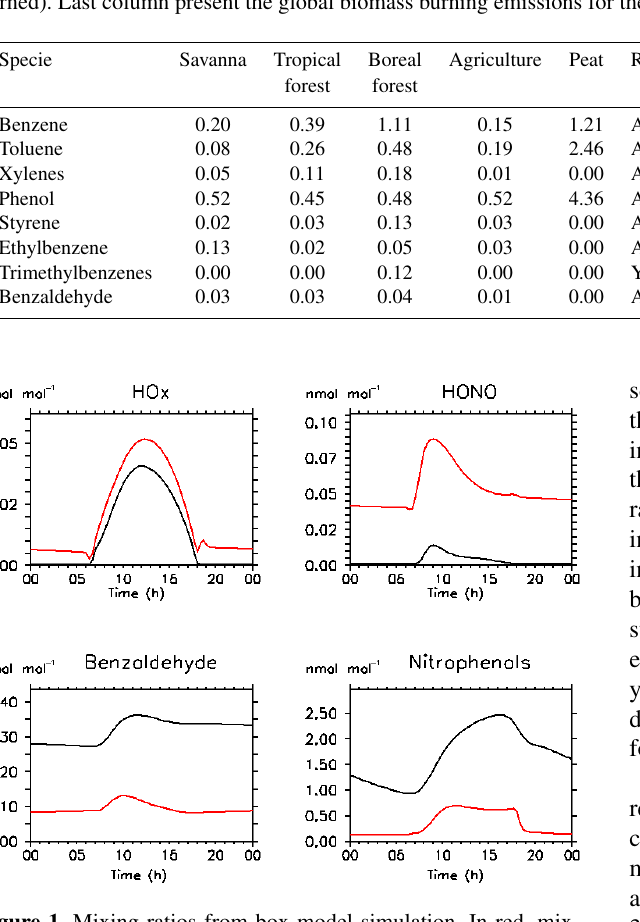
Table 3. Biomass burning emission factors for the BIOBURN submodel. Emission factors are given in units of g (species) / kg (dry matter burned). Last column present the global biomass burning emissions for the year 2005.